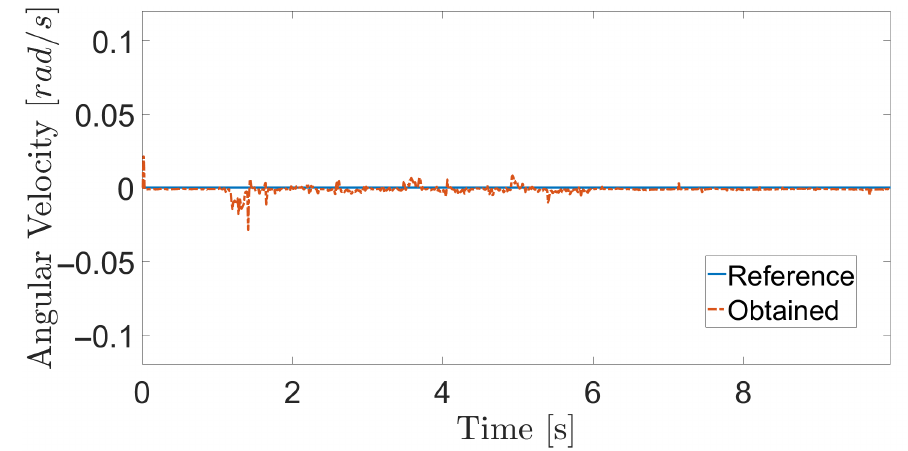
Figure 18. Angular velocity in the adhesion loss experiment.